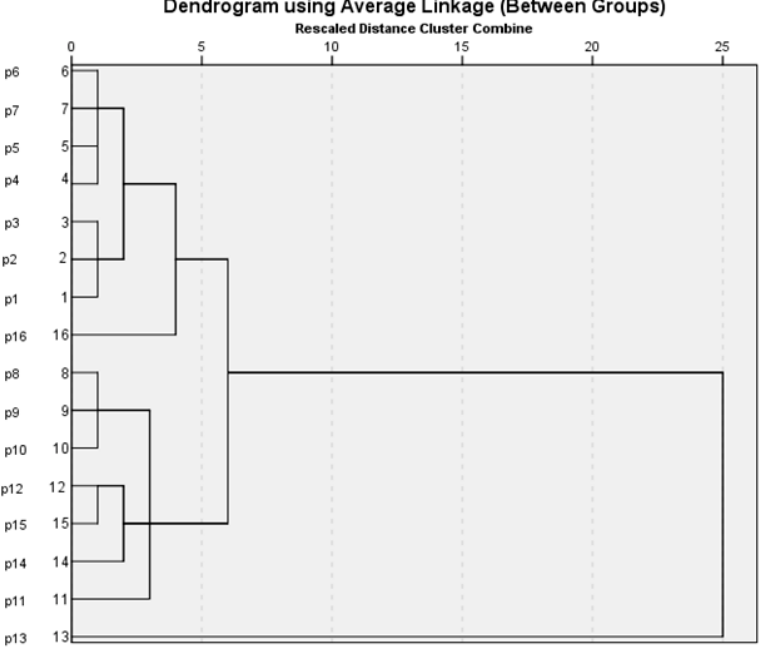
Figure 8. Clustering analysis of palynological data of taxa: Plant name p1— Ajuga reptans ; p2—